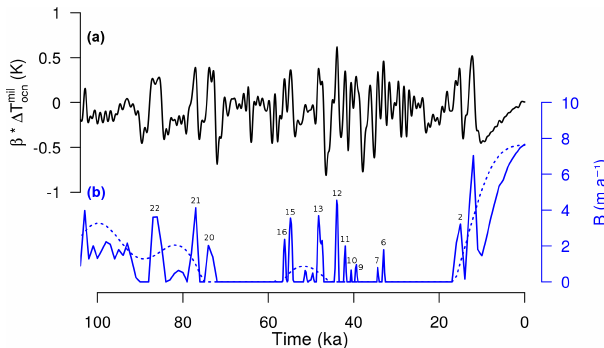
Figure 4. Evolution of (a) millennial-scale subsurface oceanic temperature as defined in Eq. (6) to force the TOT max simula- tion and (b) the resulting submarine melting used in both TOT max (solid line) and ORB max (dashed line) simulations for the last 100kyr. Submarine melt peaks are associated with their correspond- ing Greenland stadials